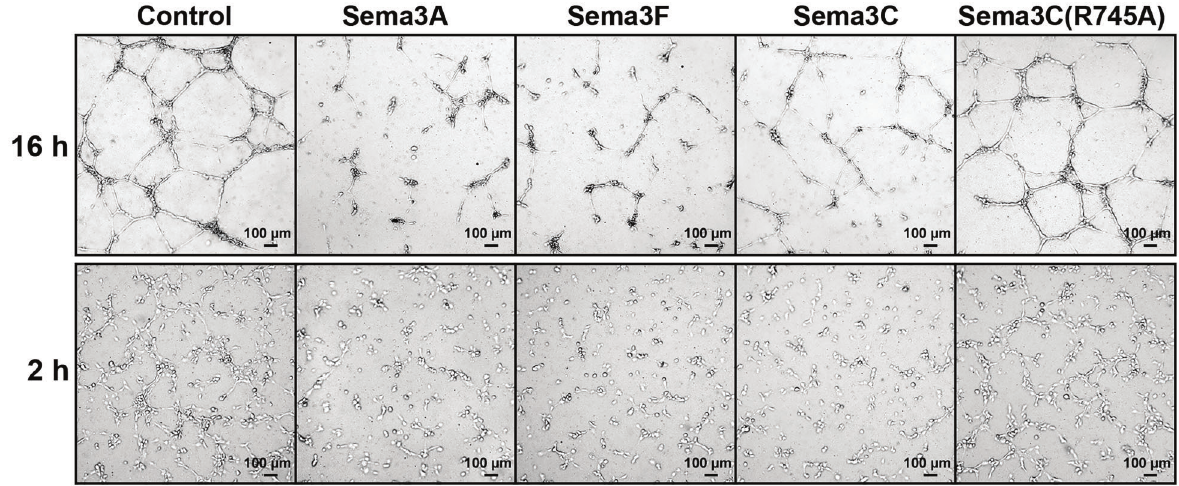
Figure 2. Effects of Sema3A, Sema3F, Sema3C, and Sema3C (R745A) proteins on microcapillary network formation by human umbilical vein endothelial cells after 16 and 2 h. Scale bar, 100 m